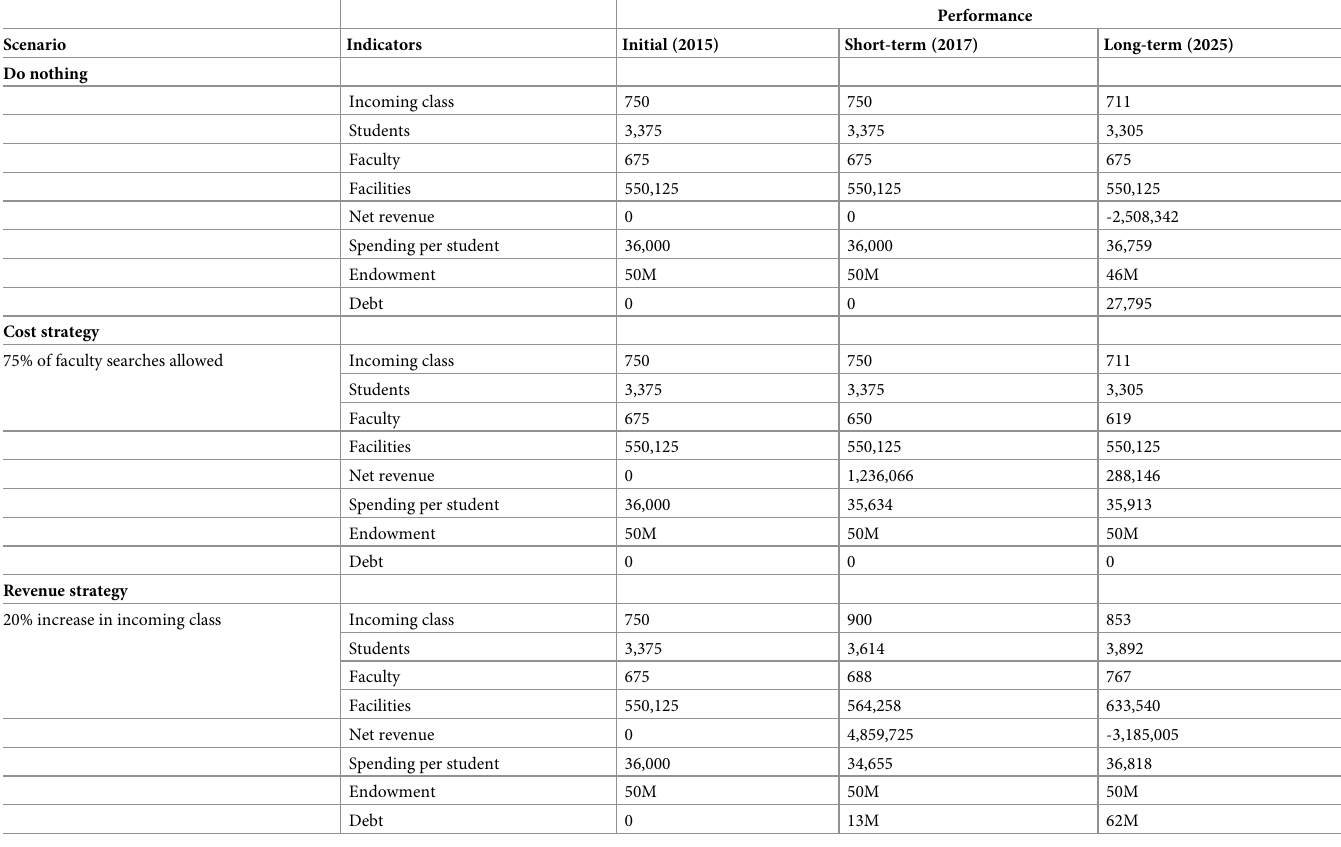
Table 4. College performance when application decline by 10 percent.